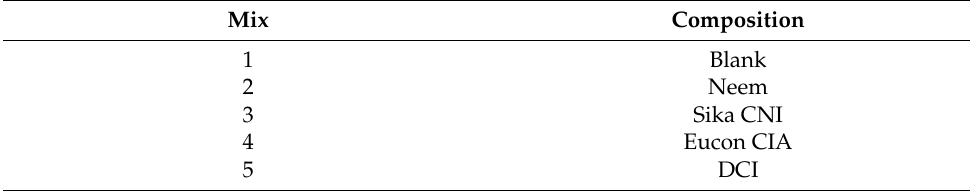
Table 5. Types of concrete mixtures.